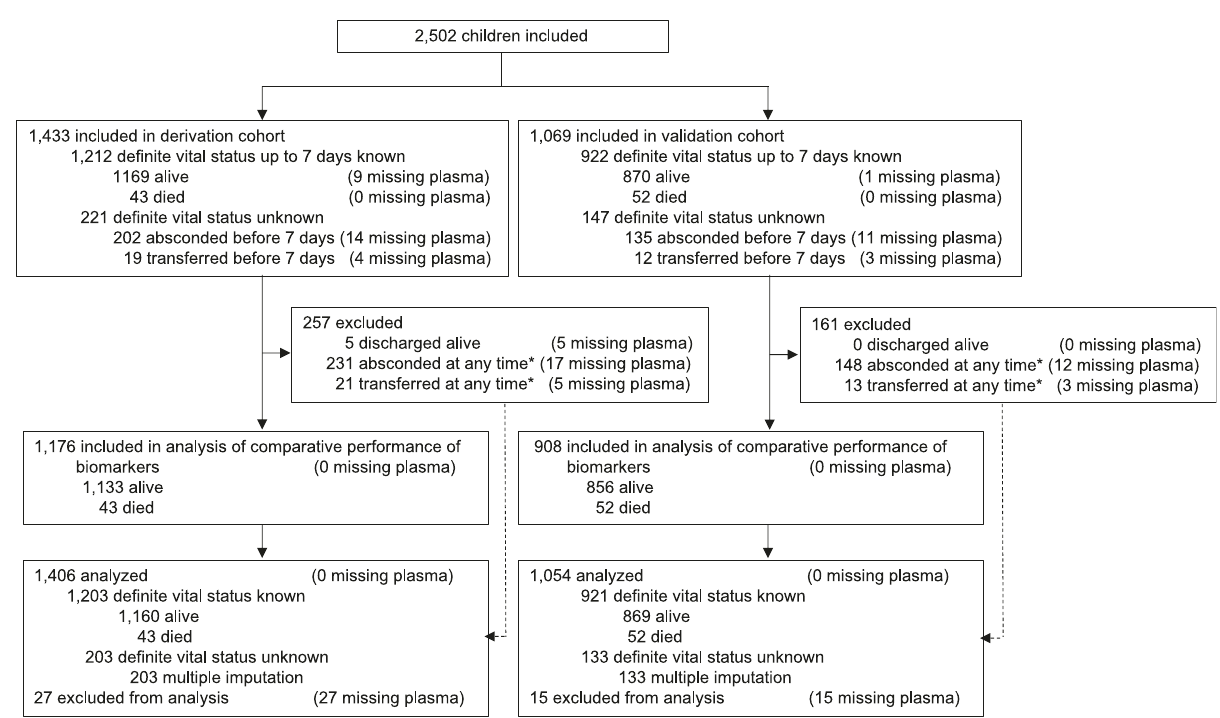
Fig. 1 Flow of consecutively enrolled children in the prospective cohort and included in analysis. In the derivation cohort, 29 children absconded after 7 days and 2 children were transferred after 7 days; in the validation cohort, 13 children absconded after 7 days and 1 child was transferred after 7 days; by de fi nition, the vital status up to 7 days was known for these children, but they were excluded from the analysis of comparative performance of biomarkers.